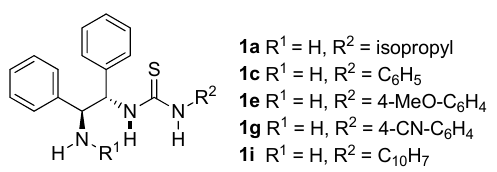
Figure 2. DPEN and thiourea based catalysts.